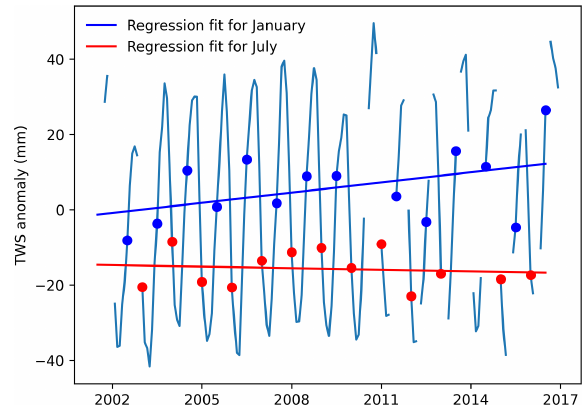
Figure B1. Illustration of the calculation of interannual variability for the global terrestrial water storage (TWS) anomalies.